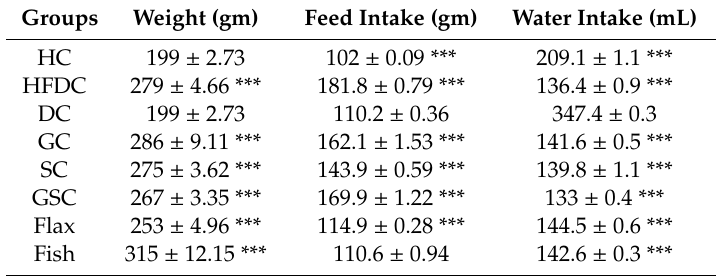
Table 3. Average body weight, feed, and water intake of the experimental groups.